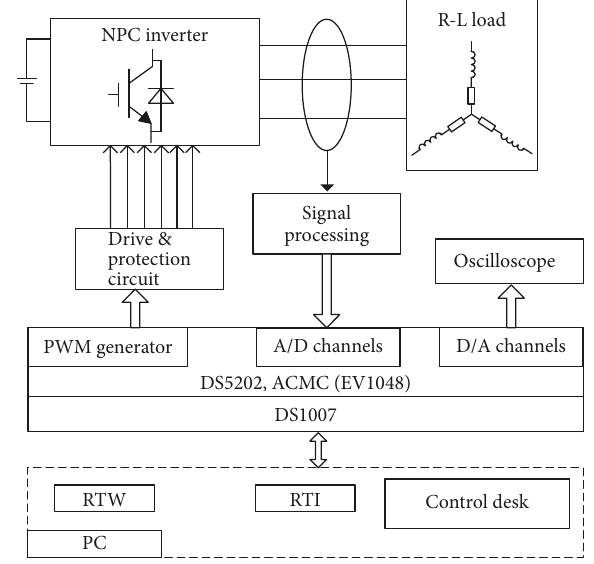
used for AD sampling but also generate PWM signal to drive the inverter circuit. In the experiment, the QA1 open fault is set up and fault-tolerant control is carried out. Figure 10 shows the different experimental waveforms of the output voltages, current, and capacitor neutral-point voltages without and with fault-tolerant control in